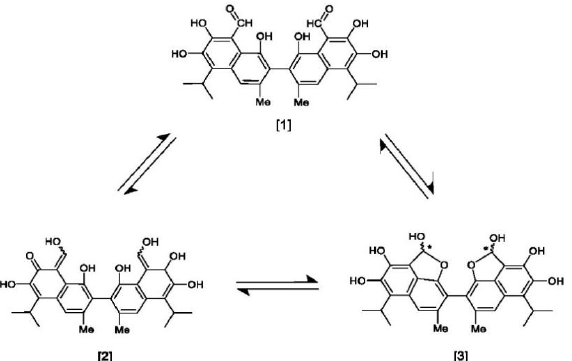
Figure 3. Symmetrical tautomeric forms of gossypol: [1] dialdehyde, [2] diketone, and [3] dilactol (* indicates a new asymmetric center in the molecule).